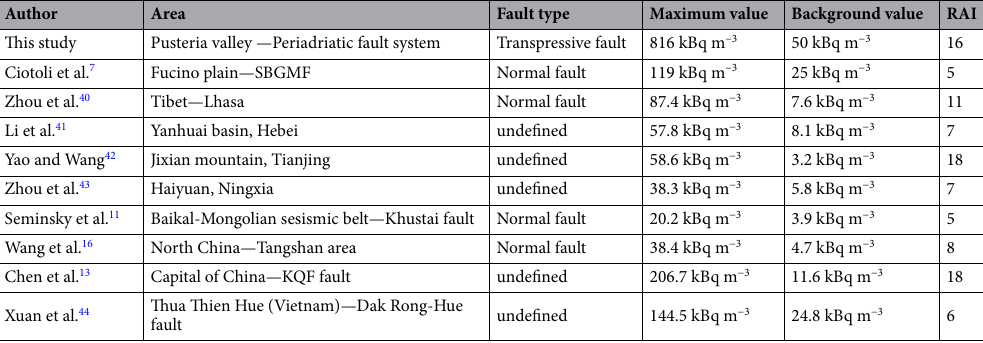
Table 2. Values of RAI obtained by the ratio between the maximum value measured in case study the area and the background value over different areas in the